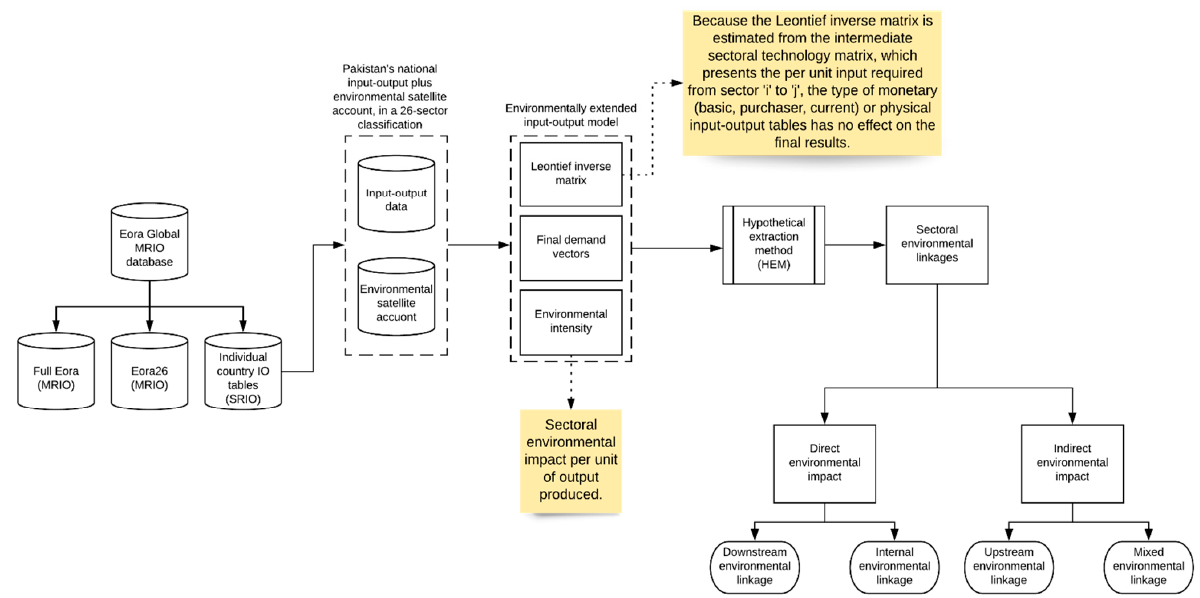
Figure 1. The flow chart of the methodology of our study. This flow chart shows how HEM, Eora MRIO, and the Pakistan database worked together and their contributions with regard to each part. As can be seen, the “Individual country IO tables” are used for this study. The “Individual country IO tables” provide Pakistan’s national IO plus environmental satellite account, in a 26-sector classification. The Pakistani national IO table for the year 2015 is provided at basic and purchasers’ prices. Some recent studies have preferred the use of basic prices [16,17]. However, as explained above, the selection of monetary (basic, purchaser or current prices) and physical type tables has no effect on intermediate sectoral technology. Therefore, the choice of basic or purchaser price does not impact the results estimated based on the IO data. Here, SRIO = Single regional IO, and MRIO = Multi-regional IO tables. The “environmental impact value” is defined and scaled based on the “Eora Satellite Accounts”. The details about the definition and scaling procedure for each of the environmental impacts are explained in “Eora Satellite Accounts: Method and Data Notes”, available at https://worldmrio.com/IndicatorNotes.doc (accessed on 4 September 2021).